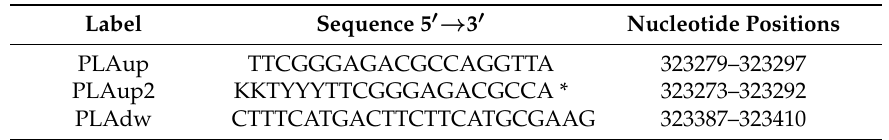
Table 1. Oligonucleotides designed in this study and respective positions in the 16S rRNA gene of